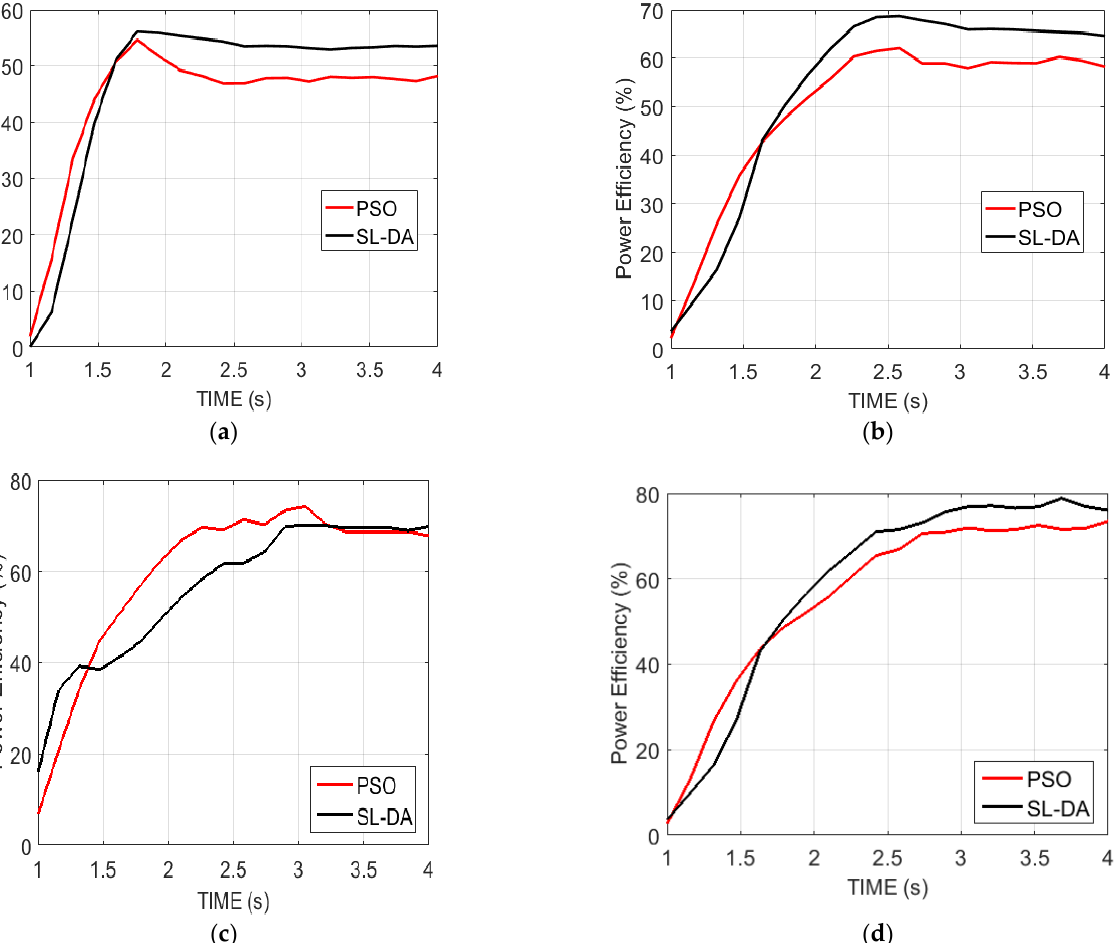
Figure 9. Analysis on the power efficiency of the proposed work over PSO: ( a ) speed 90 and torque 130; ( b ) speed 120 and torque 150; ( c ) speed 150 and torque 180; and ( d ) speed 180 and torque 200.